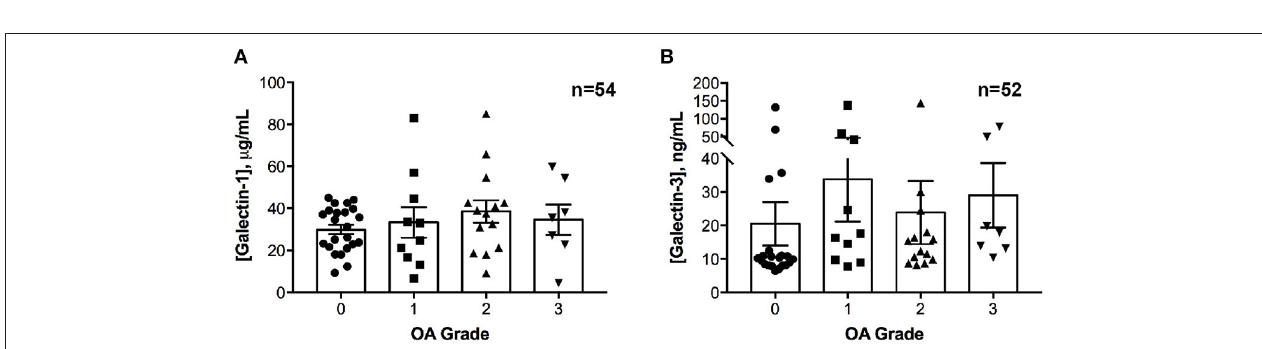
FIGURE 2 | Galectin-1 and-3 concentrations in equine synovial fluid obtained from carpal joints of horses with naturally occurring osteoarthritis (OA), classified by severity as mild (1), moderate (2) or severe (3) and from healthy carpal joints (0). Individual data are shown as scatterplots, in addition to means ± S.E.M. There were no significant differences in synovial fluid galectin-1 (A) or galectin-3 (B) concentrations between healthy and OA joints.